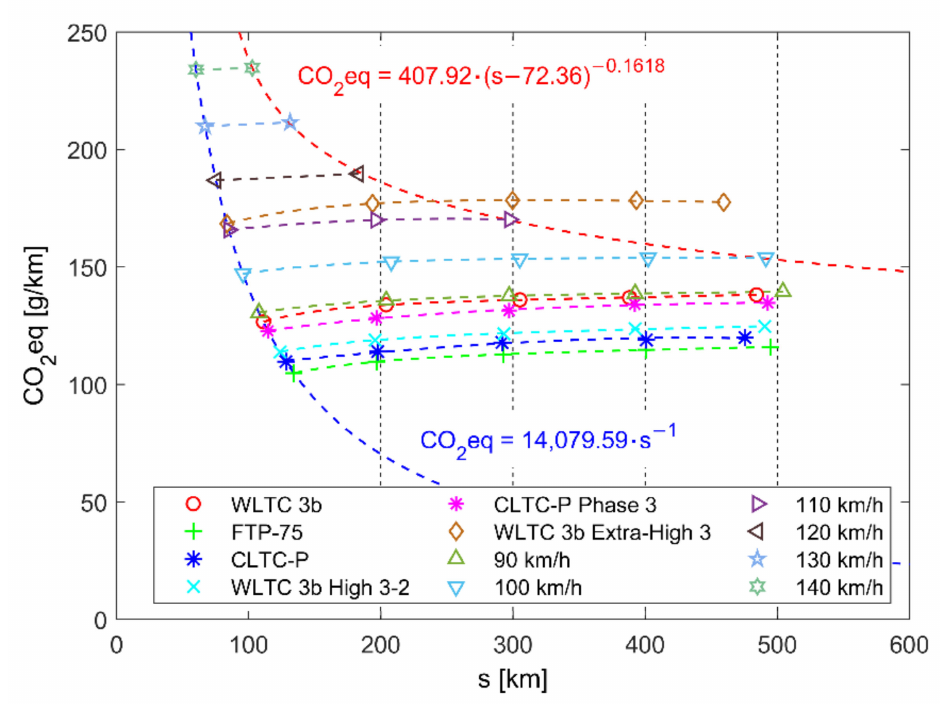
Figure A7. Combined CO 2 eq emission, due to EREV operation and electricity production (Poland), in various driving conditions. Note that the blue approximation line (BEV mode) and the red approximation line (maximal range) are obtained for constant speed driving results from the range of 90–140 km/h. Vehicle mass is equal to 1800